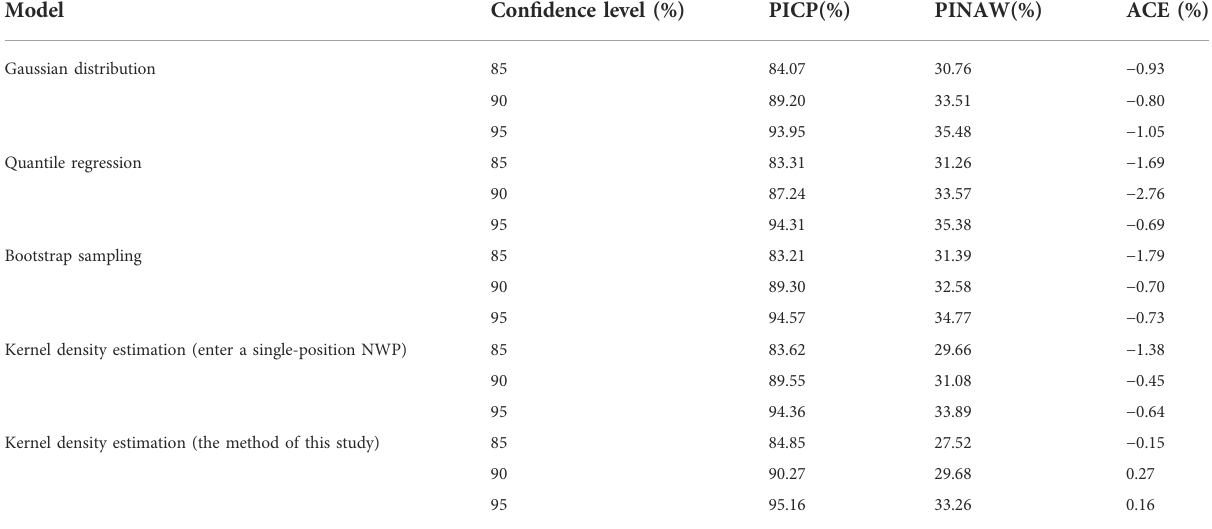
TABLE 2 Comparison of prediction evaluation indicator of each model.